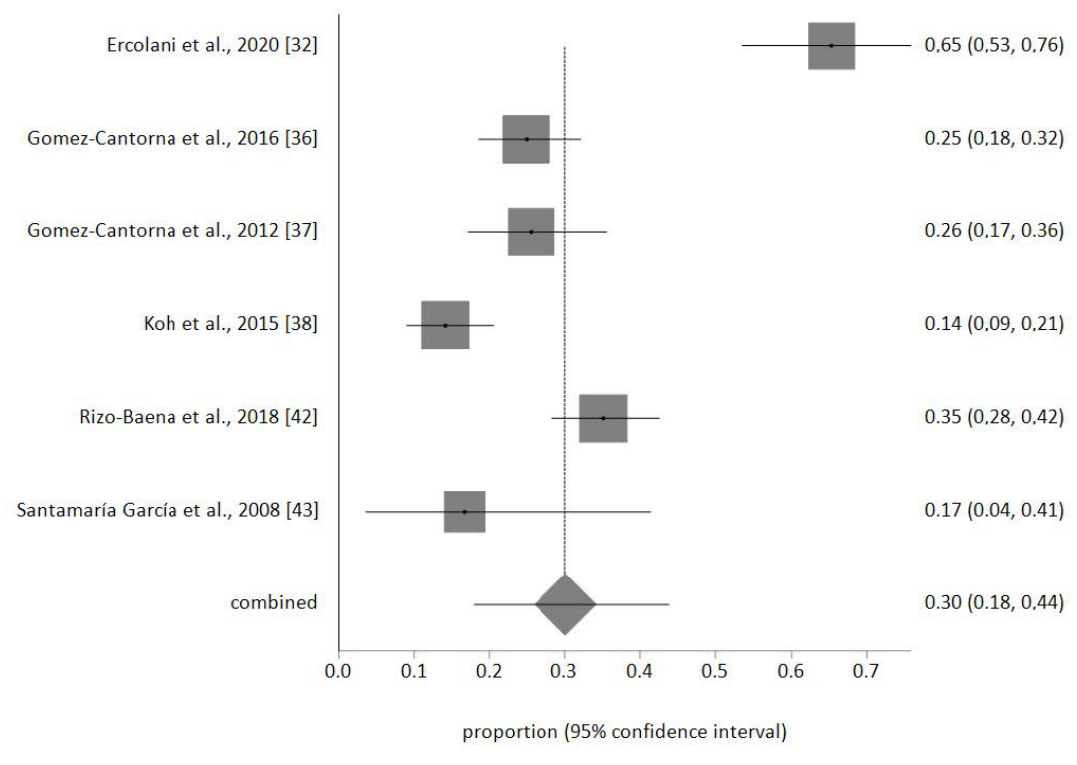
Figure 3. Forest plot of high D.